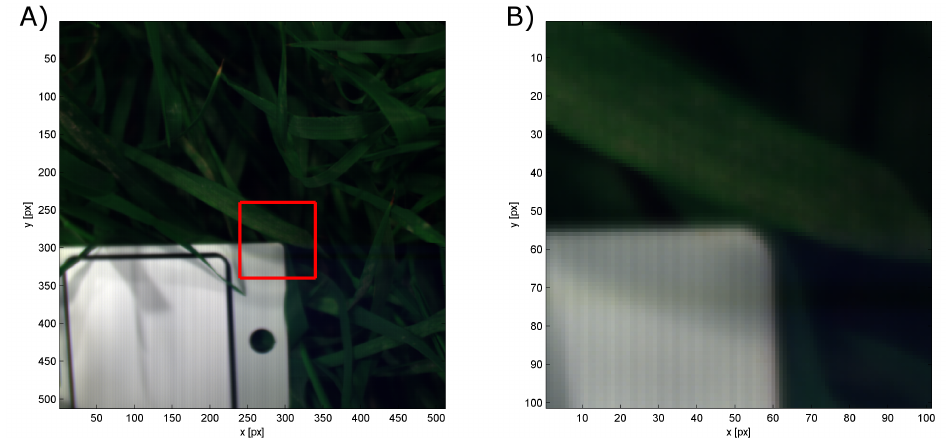
Figure 5. RGB visualization of a reflectance test image to show the line pattern. The highlighted image part in ( A ) is visualized in zoom view in ( B ). On the white reference the line pattern is visible, whereas on the plants it is mainly covered by natural